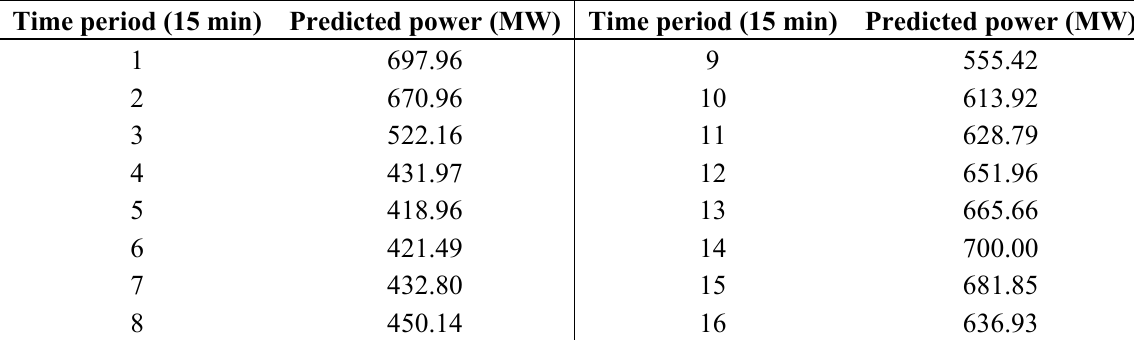
Table 2. Predicted wind power output